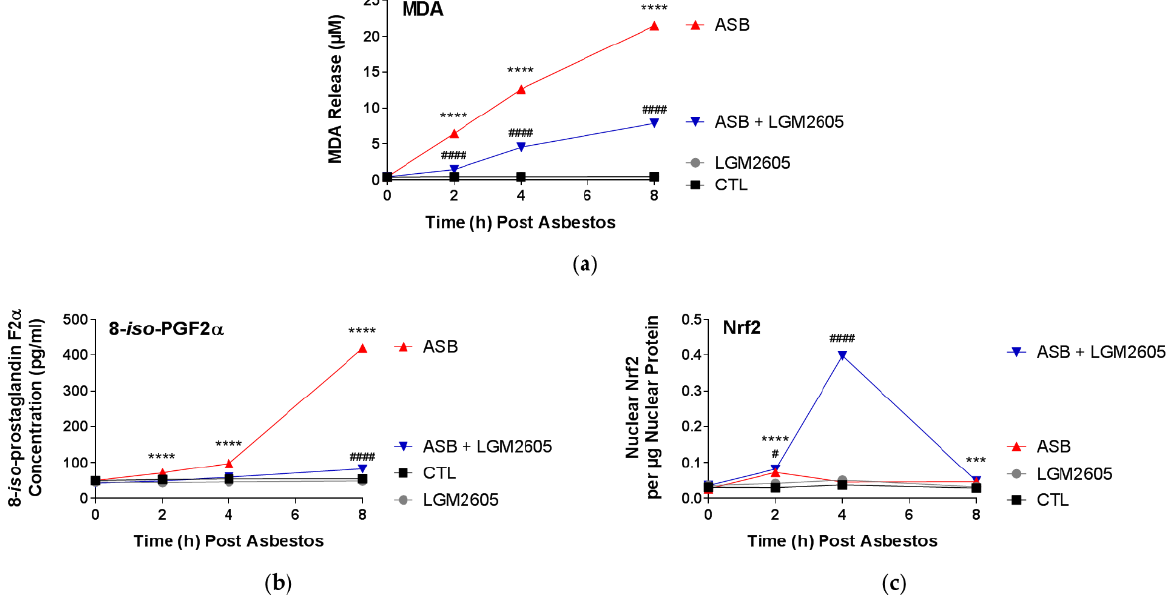
Figure 3. LGM2605 Reduces Markers of Oxidative Cell Damage and Activates Nrf2. Human pleural mesothelial cells were plated in a 6-well plate (1 × 10 6 cells/well) and exposed to 50 µM LGM2605 4 h prior to exposure to sterile crocidolite asbestos fibers (20 µg/cm 2 ). The levels of MDA ( a ) and 8- iso - PGF2α ( b ) were determined in the cell culture medium at 0, 2, 4, and 8 h post asbestos exposure. Levels of Nrf2 were determined in cell nuclear extracts ( c ). Data are presented as mean ± SEM. * indicates a statistically significant difference ( p < 0.05) between ASB and CTL treated cells (*** p < 0.001 and **** p < 0.0001). # indicates a statistically significant difference ( p < 0.05) between ASB and ASB + LGM2605 treated cells (# p < 0.05 and #### p < 0.0001).